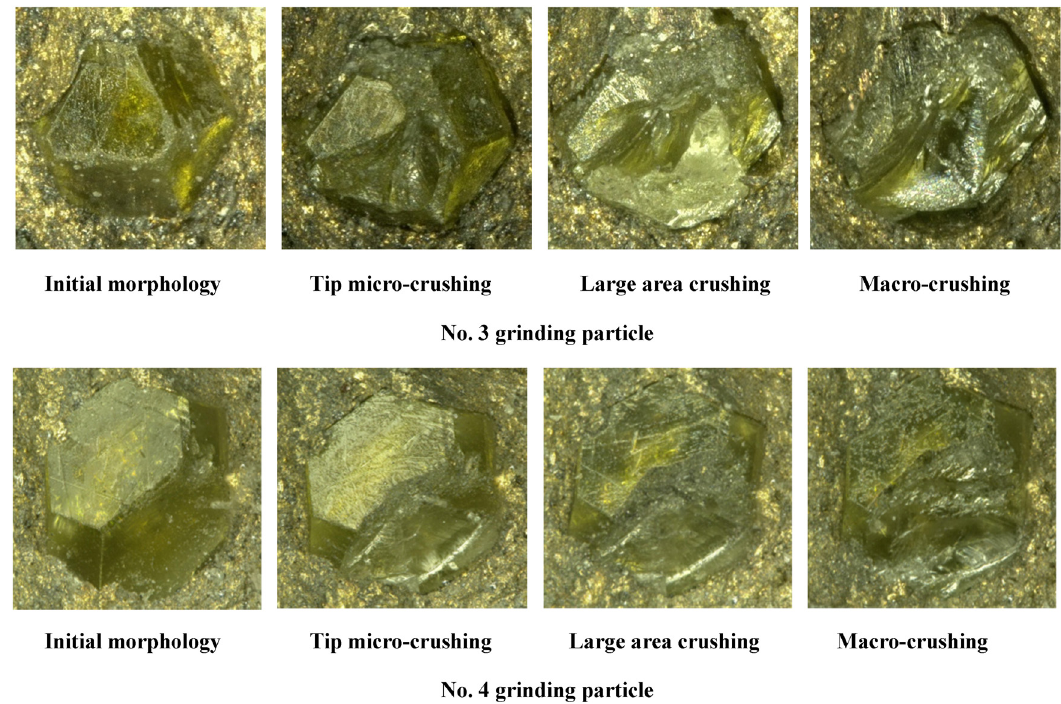
Figure 6: The morphology of the second group of abrasive particles. No. 3 grinding particle and No. 4 grinding